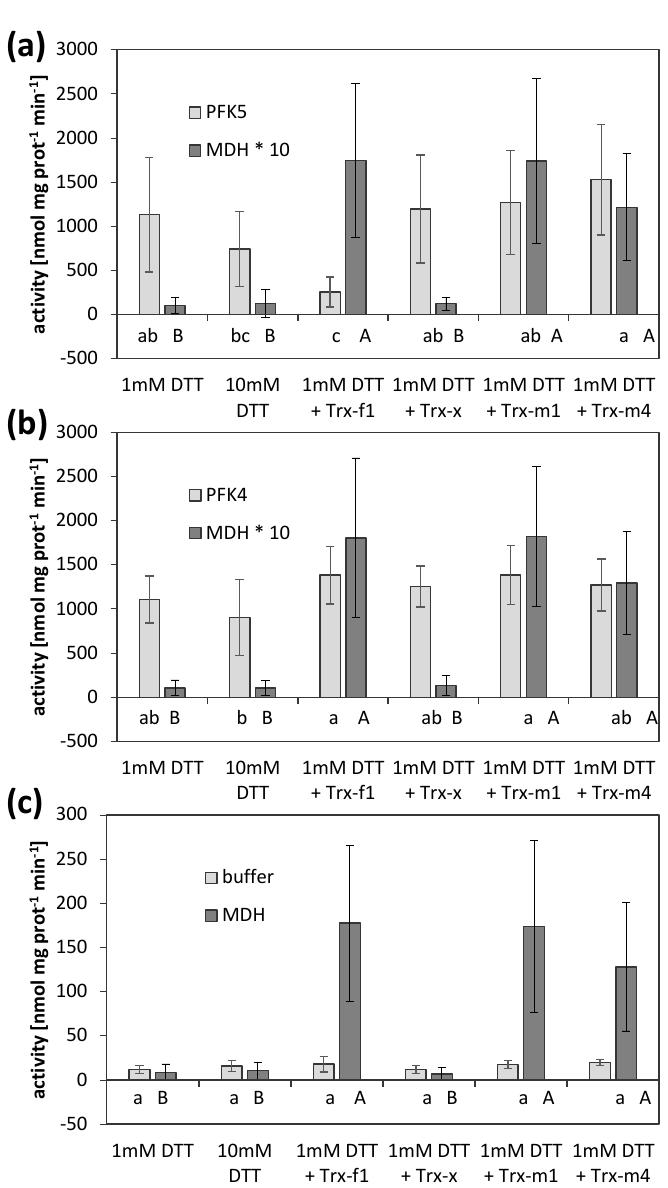
Figure 7. Thioredoxin-mediated inactivation of AtPFK5. Activities of PFK and NADP-MDH in extracts of tobacco leaves transiently overexpressing either AtPFK5 ( a ) or AtPFK4 ( b ), or mock controls ( c ). Crude leaf extracts were incubated with 1 and 10 mM DTT, or with 1 mM DTT and 5 µ M (PFK) or 2.5 µ M (MDH) of the respective TRX, and activity was measured after 30 min of incubation. Results are means ± SD of three independent infiltrations with three samples each. Upper case letters indicate significant differences among treatments for MDH, lower case letters indicate significant differences among treatments for PFK at p < 0.05 (ANOVA, Post hoc Tukey test). For comparability, MDH activity was multiplied by 10 (*) to be in the same range as PFK activity in ( a , b ).